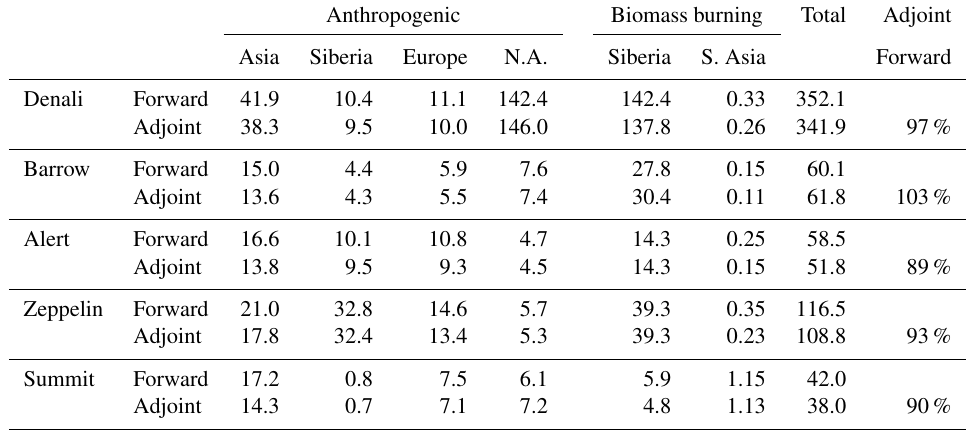
Table 2. Model-simulated relative contributions to surface BC concentration (ngm − 3 ) at selected Arctic sites (Fig. 1) for 20–25 ∗ April 2008. Anthropogenic Biomass burning Total Adjoint Asia Siberia Europe N.A. Siberia S. Asia Forward Denali Forward 41.9 Barrow